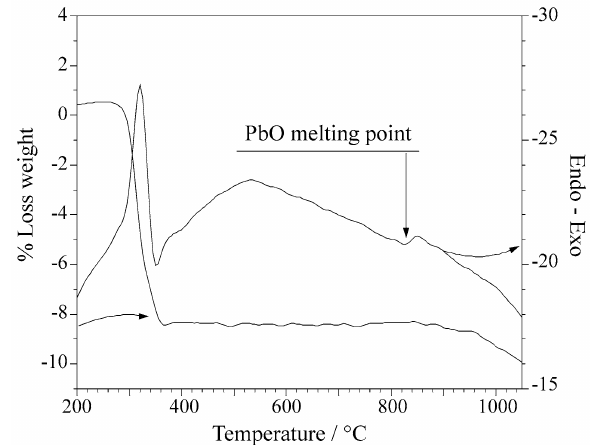
Figure 2. TG/DTA curves for the NM-lead oxalate co-precipitate.